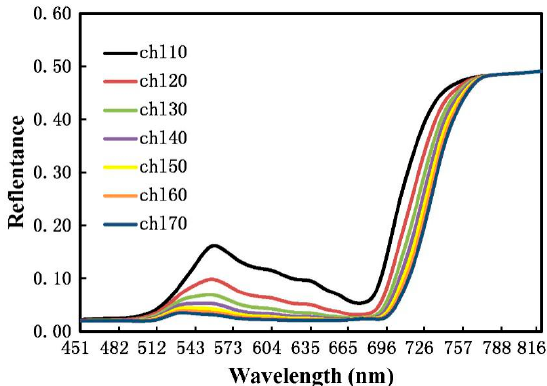
Figure 1. Crop canopy spectral reflectance with various LCCs, as simulated by the combined PROSPECT leaf optical properties model and SAIL canopy bidirectional reflectance model (PROSAIL) model.